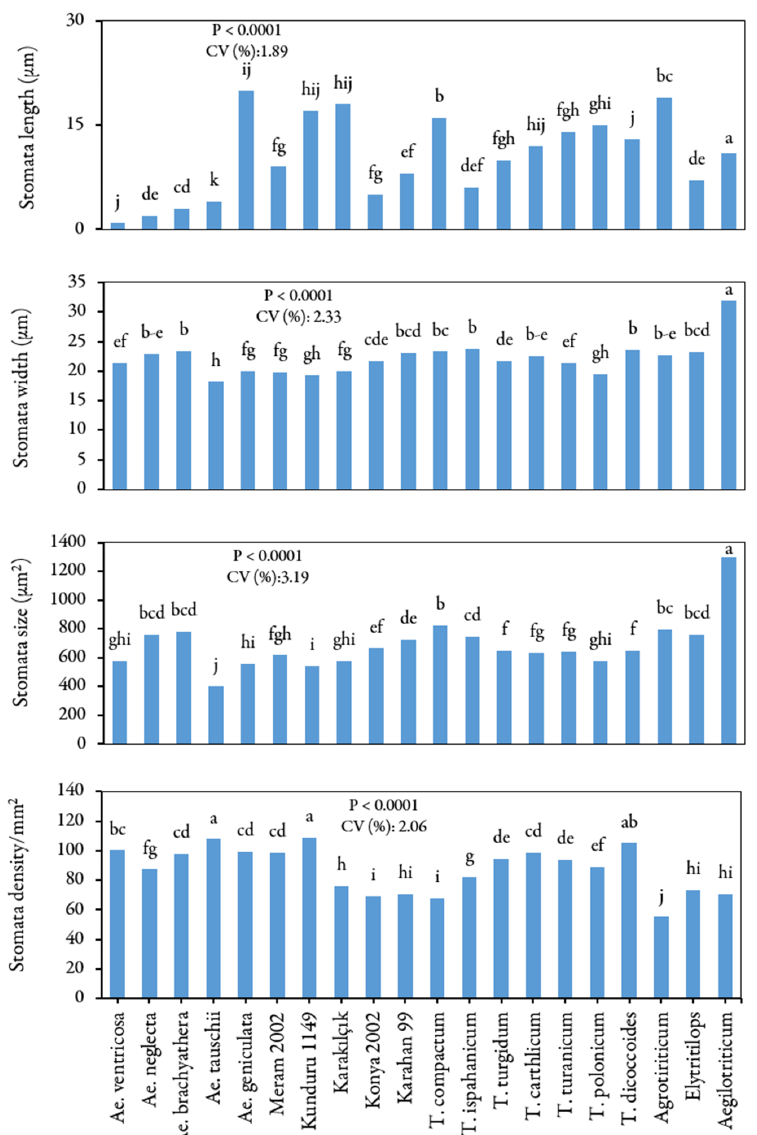
Figure 2. Stomatal length, width, size, and density of the studied genotypes In the study, the hexaploid and tetraploid genotypes were discriminated precisely in terms of stomata density. The maximum stomatal length and width were observed in the ‘Aegilotriticum’ in wheat species and hybrids. Conversely, T. dicoccoides and T. durum cv. ‘Kunduru 1149’ had the lowest stomatal length and width, respectively. In general, the hexaploid wheat genotypes and hybrids possessed a higher stomata size compared to tetraploid wheat genotypes. In Aegilops species, Ae. tauschii , a unique genitor of bread wheat, indicated the lowest stomatal length and width (Figure 2). However, the highest values were obtained from Ae. brachyathera